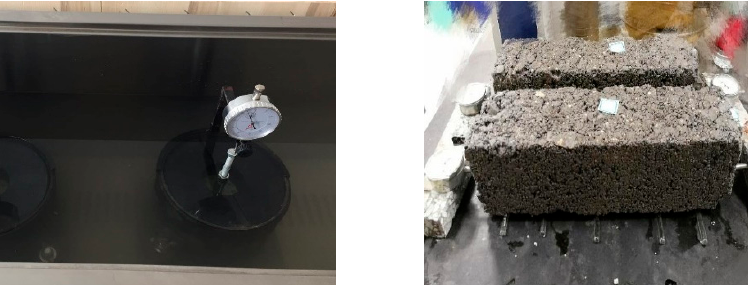
Figure 7. Volumetric properties test.